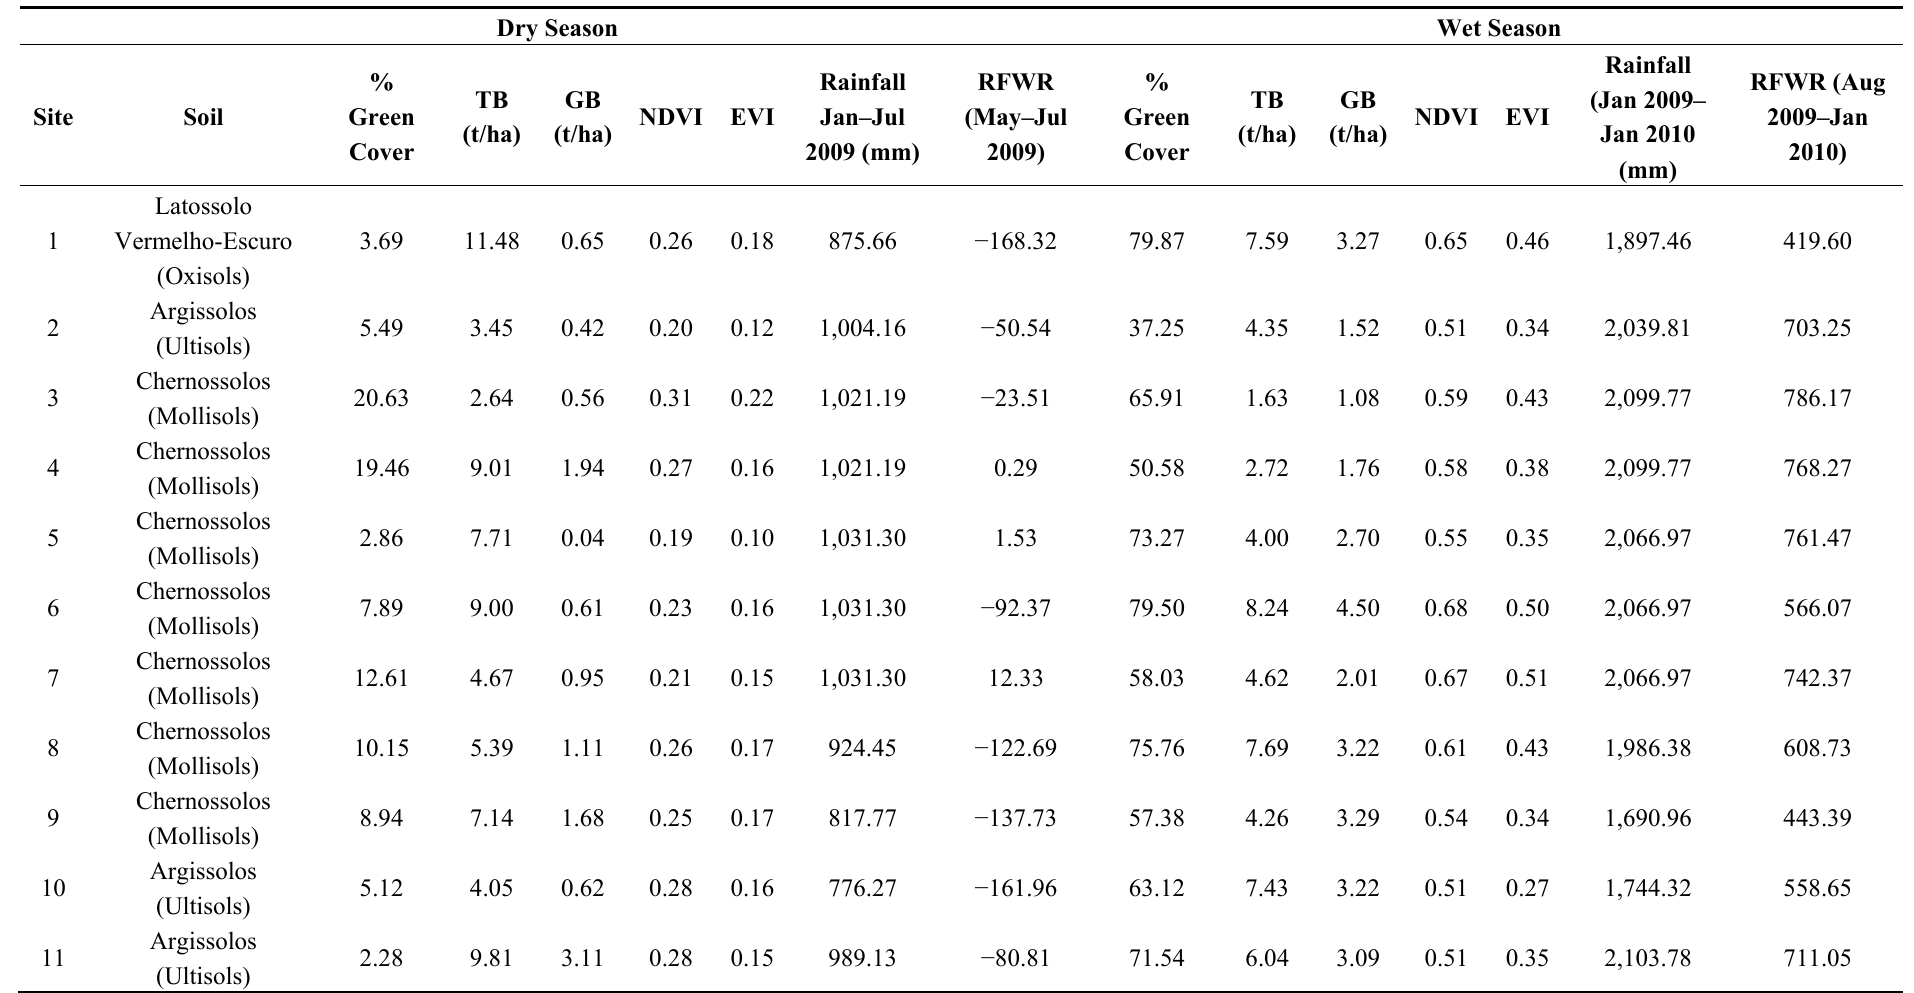
Table 1. Dry and wet season biophysical, radiometric and climatic data for the 27 field sites considered in this study. No burning activity was verified during the time period considered in this study. TB = total biomass; GB = green biomass; NDVI = normalized difference vegetation index; EVI = enhanced vegetation index; RFWR = renewable fresh water resources; CV (coefficient of variation); na (not available Landsat data, due to cloud